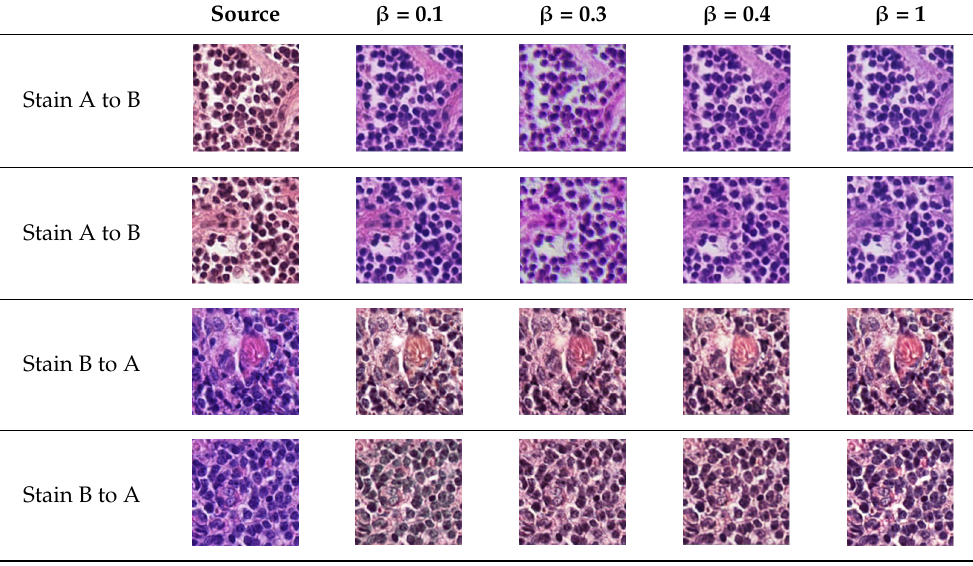
Table 3. Stain Transfer Results Obtained with the S3CGAN When Using Different β Values.